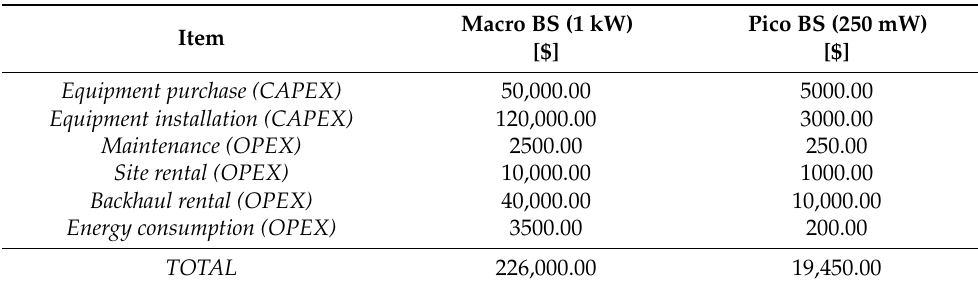
Table 1. Capital expenditure (CAPEX) and operating expenses (OPEX) in 2-tier Heterogeneous Cellular Network (HCN), also commonly referred to as HetNet,